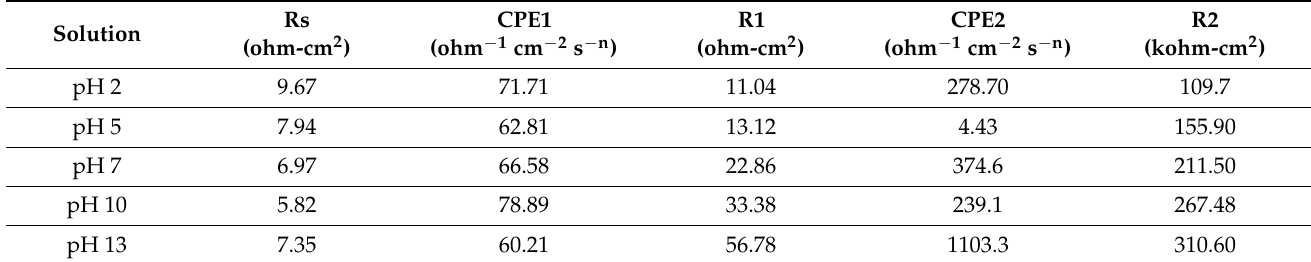
Table 5. EIS fitting data of 2205 DSS in 3.5% NaCl solution with different